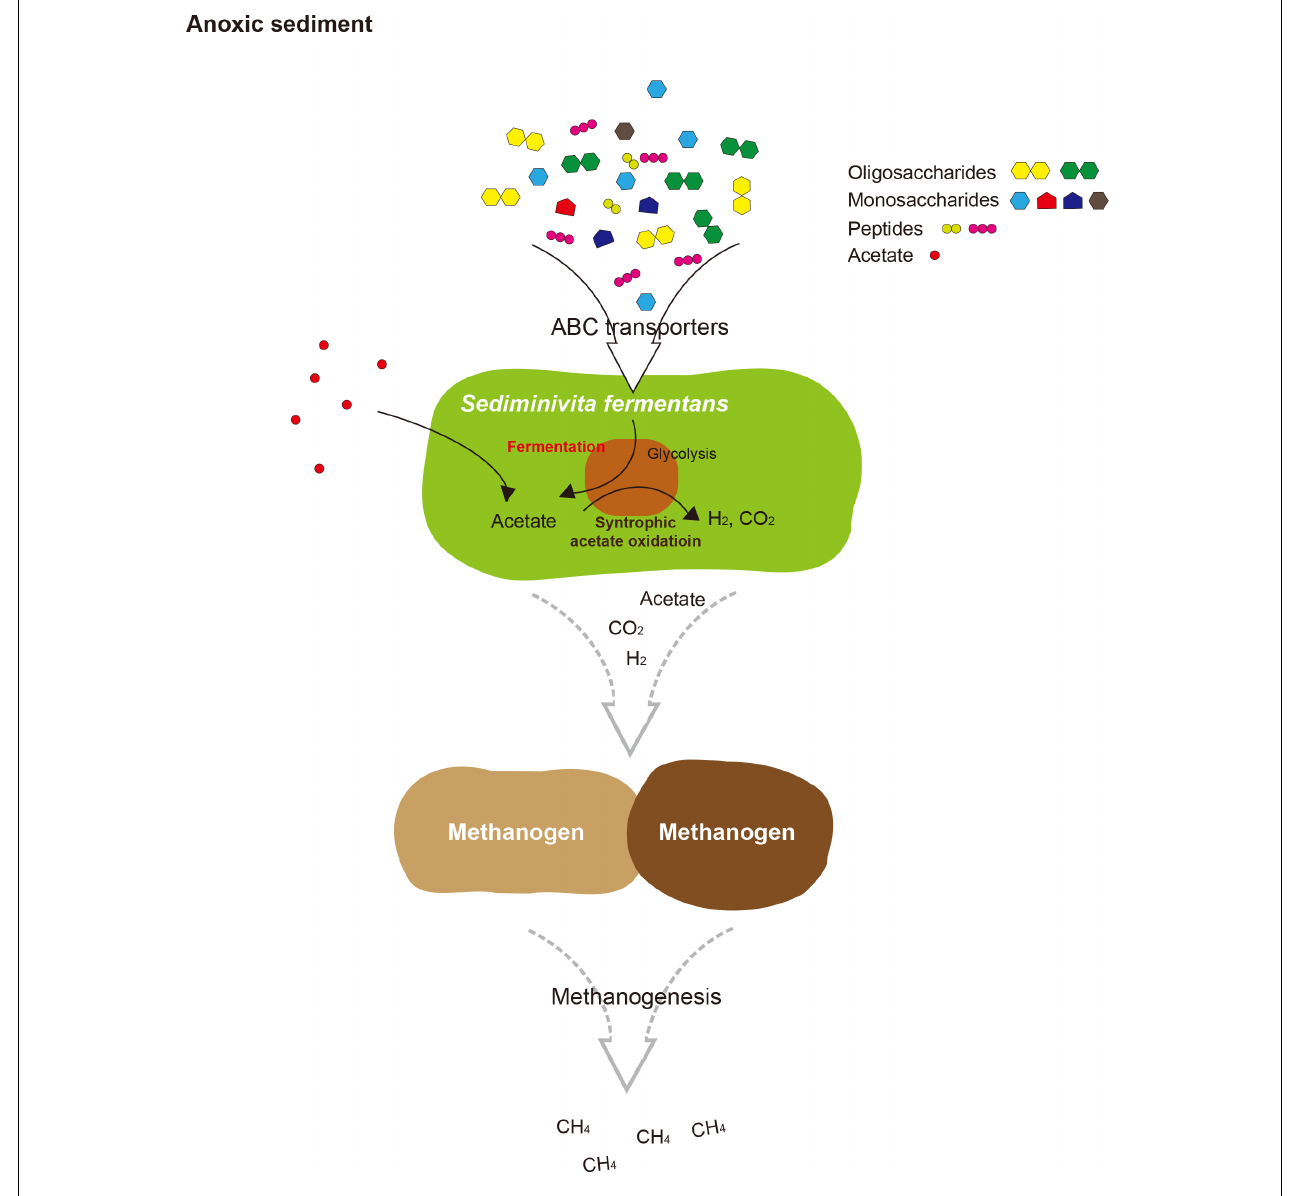
FIGURE 5 | Proposed schematic interactions of Sediminivita fermentans with methanogens and importance in carbon cycling. Sediminivita fermentans ferments pyruvate produced in glycolysis of various amino acids and sugars producing acetate, and also oxidizes acetate producing hydrogen and carbon dioxide via syntrophic association with hydrogen-scavenging methanogens. The resulting acetate, hydrogen and carbon dioxide can support methanogenesis in anoxic sediments.